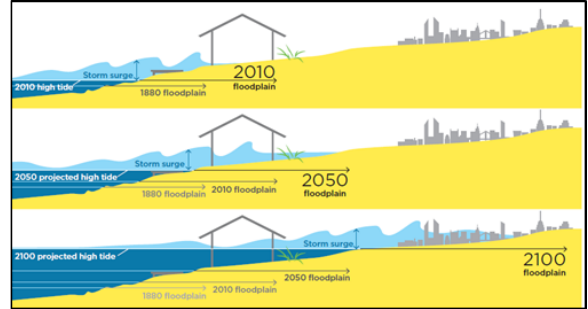
Figure 3. Sea Level Rise (Source: UCS,